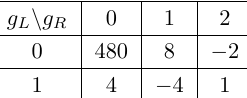
Table 10 . The refined GV numbers n g L ,g R the integer basis.